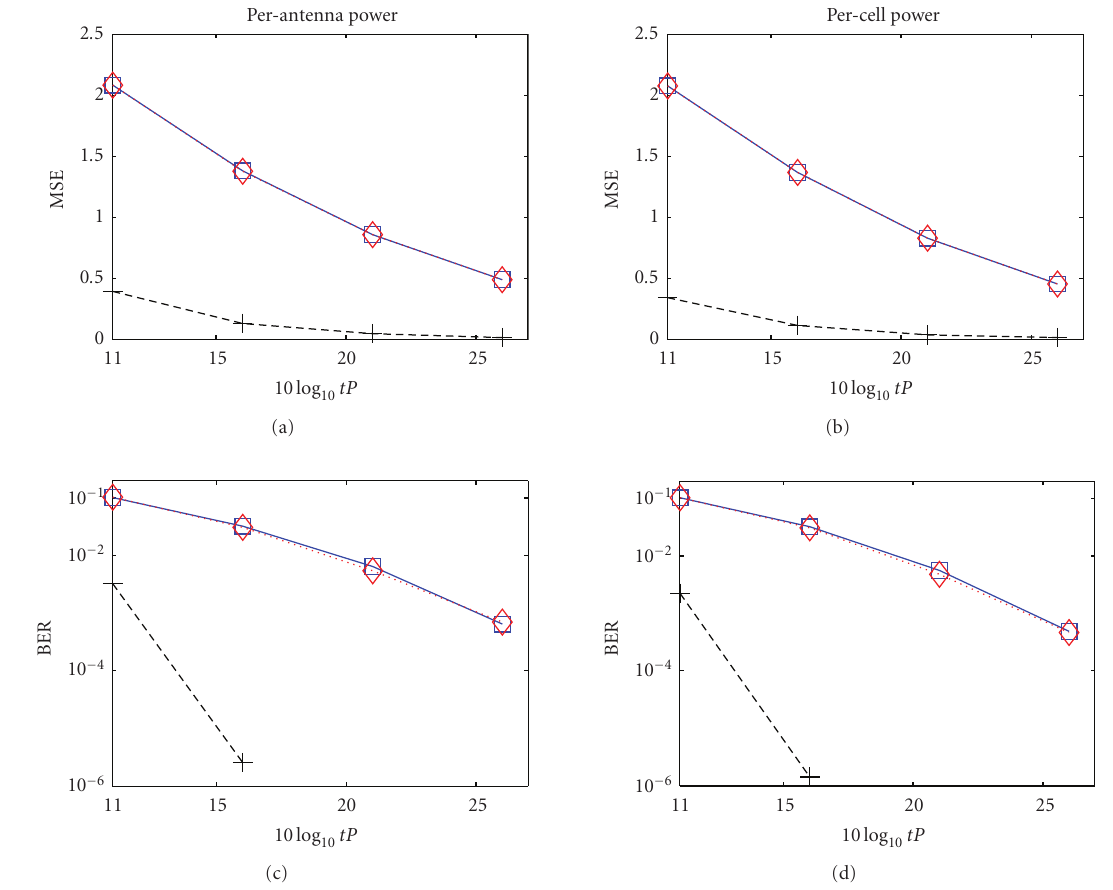
Figure 2: MSE and BER as functions of 10log tP under per-antenna and per-cell power constraints. System parameters are shown in 10 examples 1 and 2 in Table 1. ( Legends: Solid square lines: the DCOA with ( m 1 , m 2 ) = (2,2) ; Dotted diamond lines: the GIA ( FIA ) with ( m 1 , m 2 ) = (2,2) ; Dash “ +” lines: the GIA with ( m 1 , m 2 ) = (1,1) . )